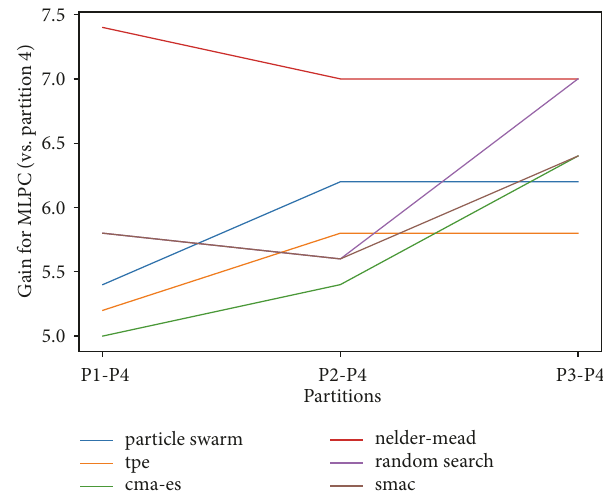
Figure 4: Average of gain for each smaller partition with respect to the whole dataset in RF.